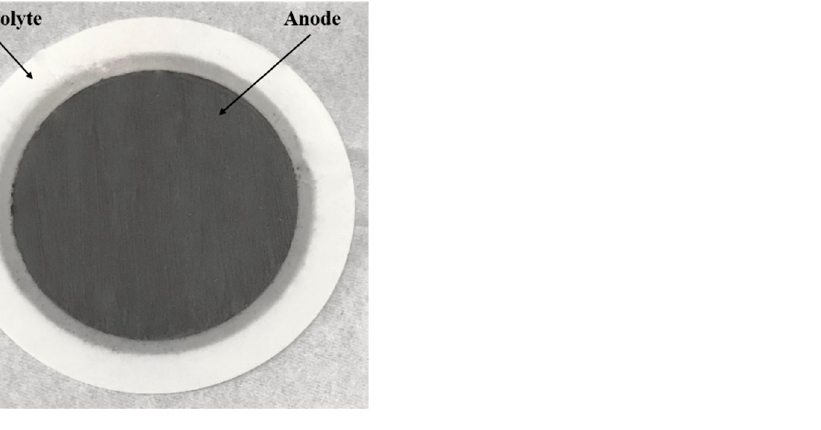
Figure 1. Electrolyte-supported cell and coated anode with an active area of 10.17 cm 2 . Silver paste was coated on the anode side of sintered cells for optimal current collection. Silver coated electrolyte-supported cells (ESCs) were sintered for 1 h at 800 °C in air. The prepared cells were assembled in a Fiaxell assembly as shown in Figure 2. Nickel mesh was used in the cell fixture for current collection on the anode side while a gold mesh was used on the cathode side. A mica sheet was used as sealant to provide hermetic sealing between the fuel and the air chambers of the cell fixture. Current collector meshes were spring-loaded to provide firm contact between the current collector mesh and cell and to ensure sealing.